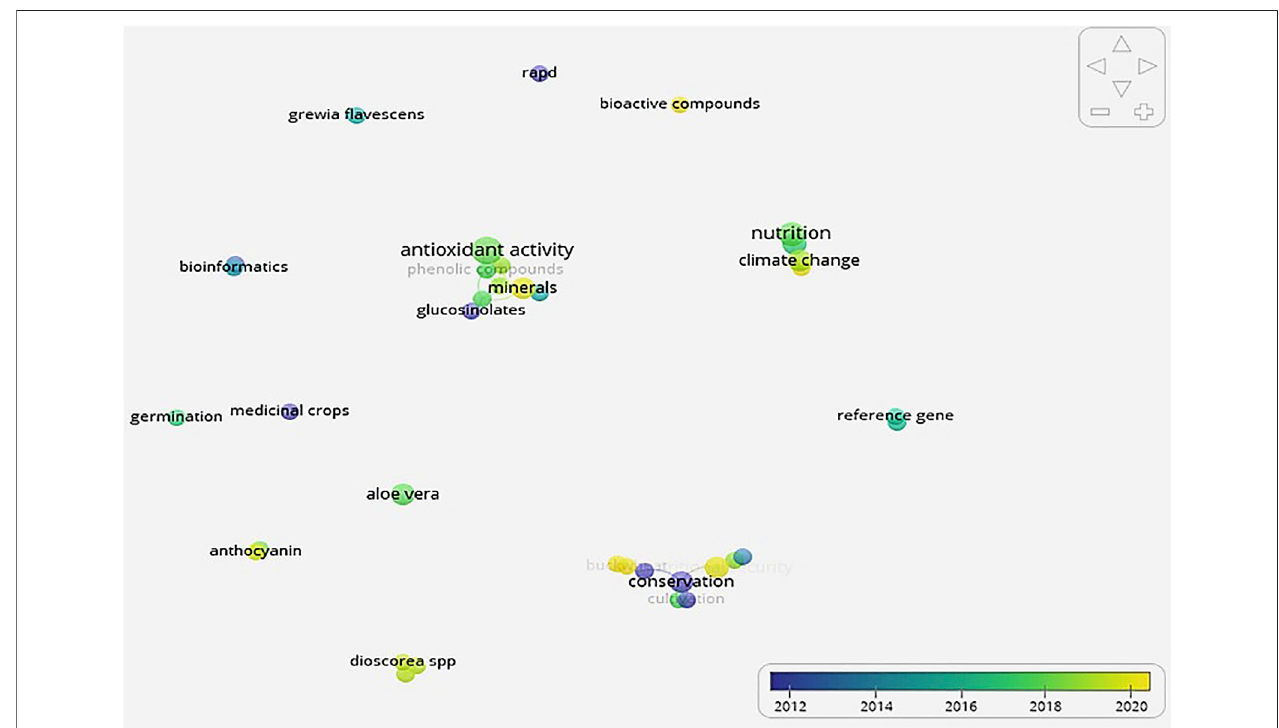
FIGURE 2 | Direction and revolution of topical concepts on neglected and underutilised functional medicinal crops (NUFMS) derived using data from titles and abstracts in VosViewer.